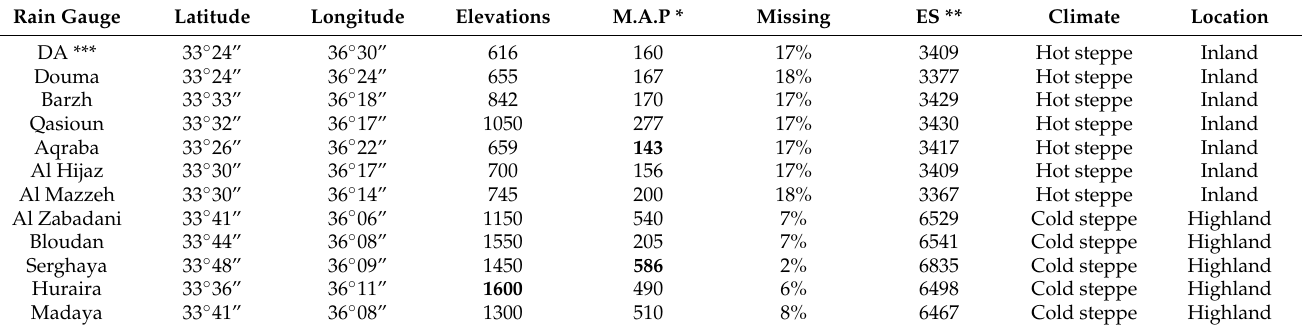
Table 1. The geographical and climatological characteristics of the rain gauges used in the Barada